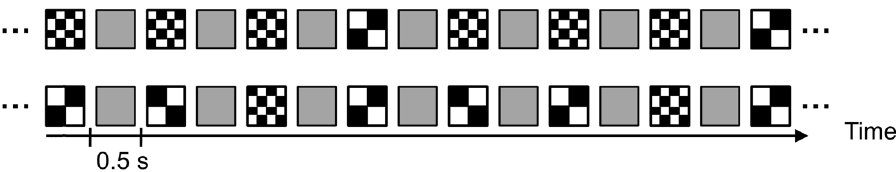
Figure 4. Checkerboard oddball paradigm. Rare checkerboards with coarse check sizes are randomly interspersed with frequent checkerboards with fine check sizes (top row, condition FF) and vice versa (bottom- row, condition CF). Participants were instructed to count the occurrences of the rare checkerboards within an experimental block. Each checkerboard (coarse or fine) was presented for 500 ms and alternated with a gray screen interval, which was also present for 500